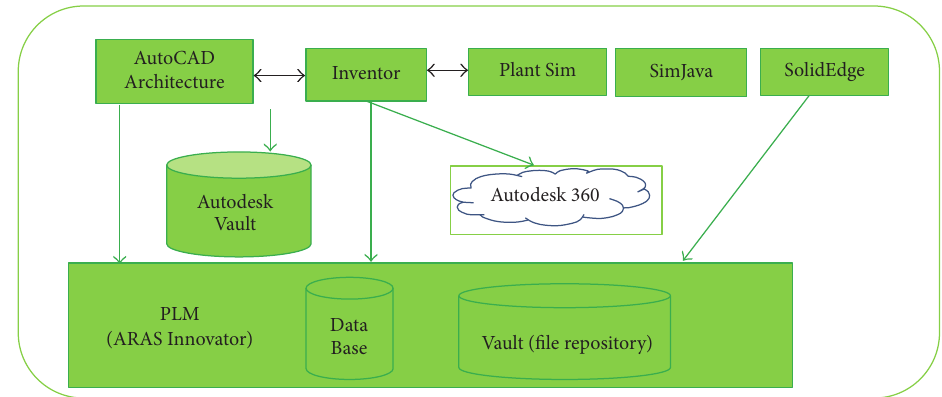
Figure 9: The system architecture of the use